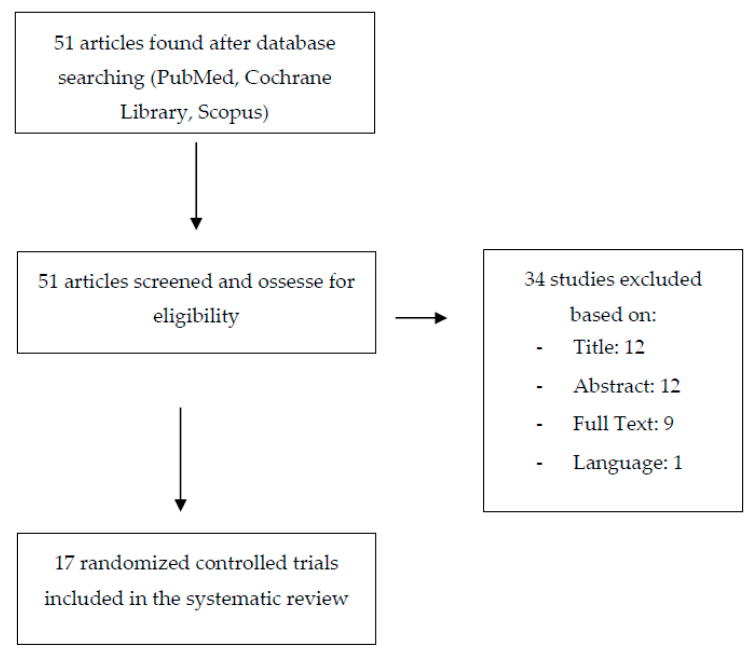
Figure 1. Flow chart of the publication assessment.